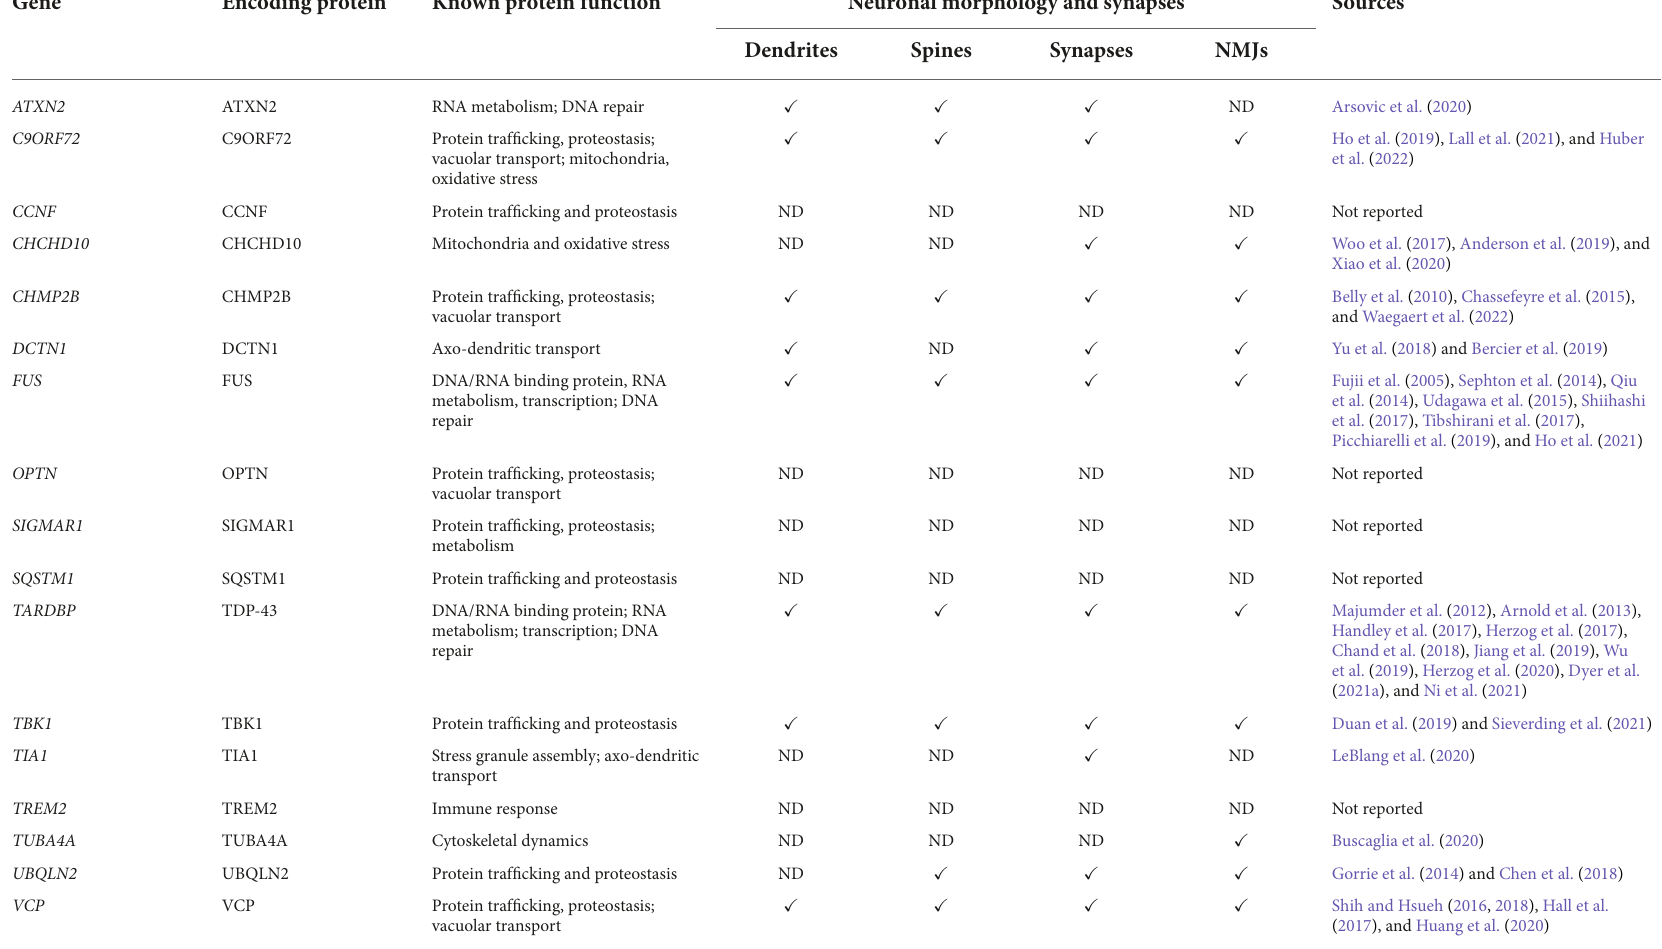
TABLE 1 ALS and FTD disease-associated gene mutations, their functions, and reported effects on neuromorphology and synapses. Gene Encoding protein Known protein